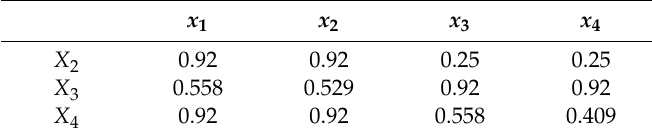
Table 15. Fuzzy reliability of each